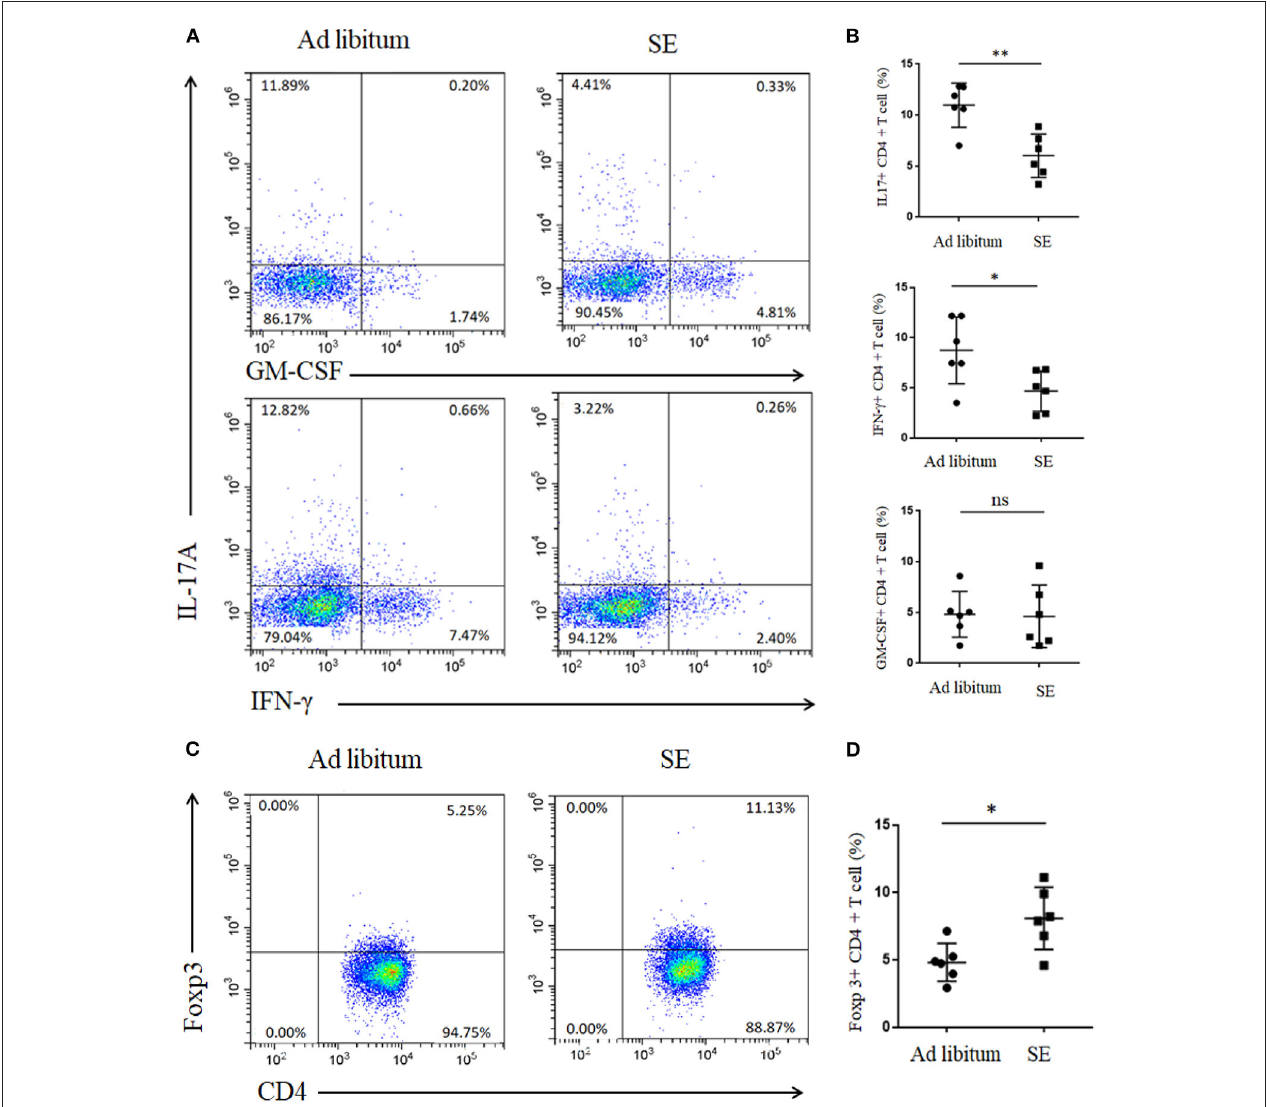
FIGURE 2 | Strength exercise diminish Th17 responses and boost Treg responses in experimental autoimmune encephalomyelitis (T3). Lymphocytes from inguinal lymph nodes (LN) were isolated 21 days post-immunization and used for assessment of different CD4 T-cell subsets ( n = 6). (A,C) Representative staining of different CD4 T-cell subsets in inguinal LN, gated on TCR β + CD4 + . (B,D) Statistical analysis of the percentages of CD4 + T cells producing interleukin-17A (IL-17A), interferon gamma (IFN- γ ), granulocyte-macrophage colony-stimulating factor (GM-CSF), and Foxp3. Each dot represents a mouse, and the bars are mean ± SD. * p < 0.05; ** p < 0.005; ns, no significance. All p -values were calculated by Mann–Whitney